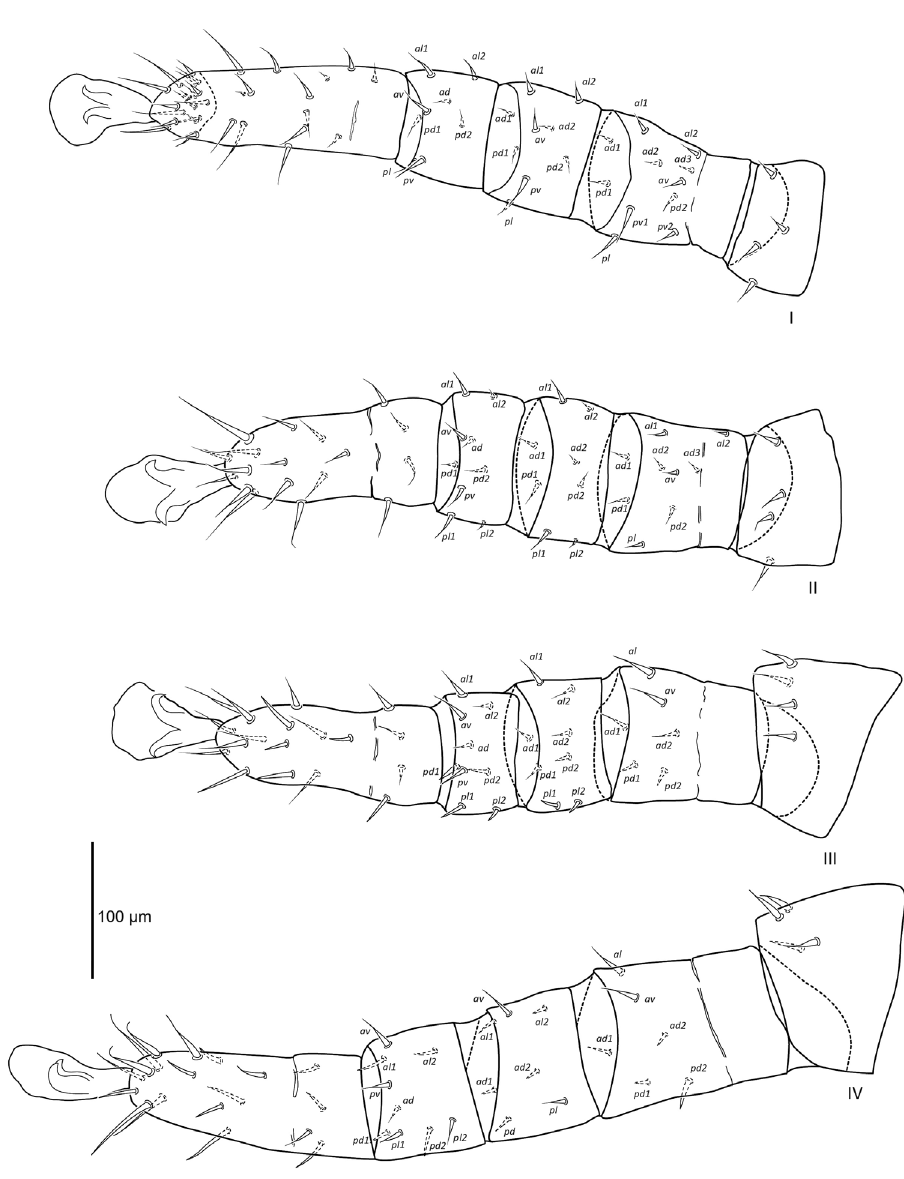
Figure 9. Female Vitznyssus erici sp. n. legs I–IV, coxae omitted. IV: coxae 2–2–2–1; trochanters 4–4–4–4; femora I (2–3/1,2/2–1), II (2–3/1,2/0–1), III (1–2/1,2/0–0), IV (1–2/1,2/0–0); genua I (2–2/1,2/1–1), II (2–2/0,2/0–2), III (2–2/0,2/0–2), IV (2–2/1,1/0–1); tibiae I (2–1/1,2/1–1), II (2–1/1,2/1–2), III (2– 1/1,2/1–2), IV (2–1/1,2/1–2); tarsi 33–18–18–18. Leg setae are setiform with fila- mentous